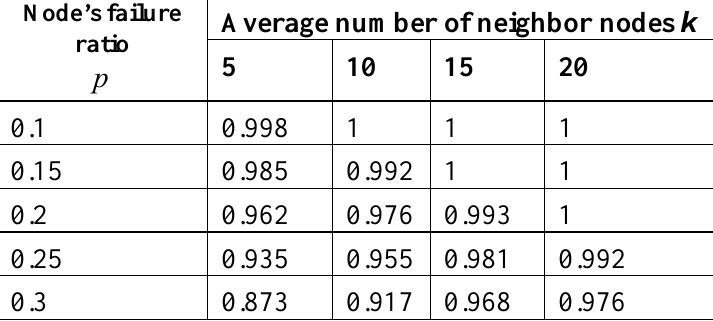
Table 1. Fault detection accuracy of DFD scheme.